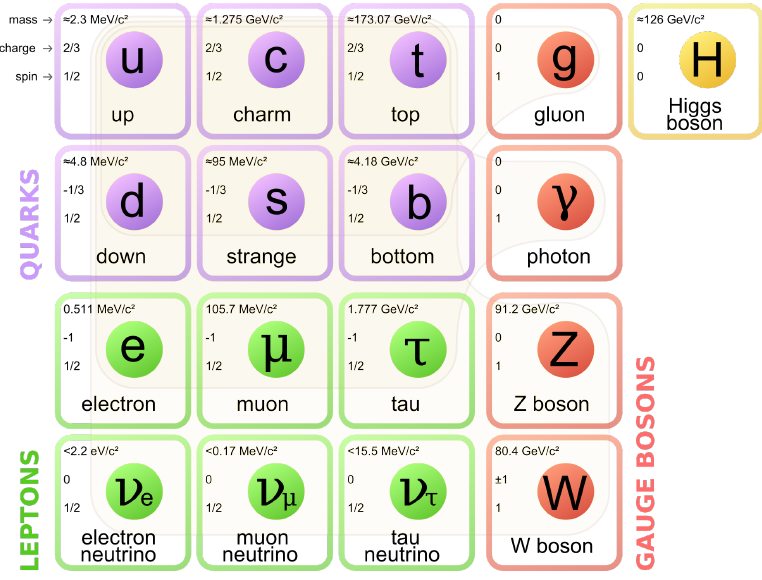
Figure 2. All particle species of the Standard Model of elementary